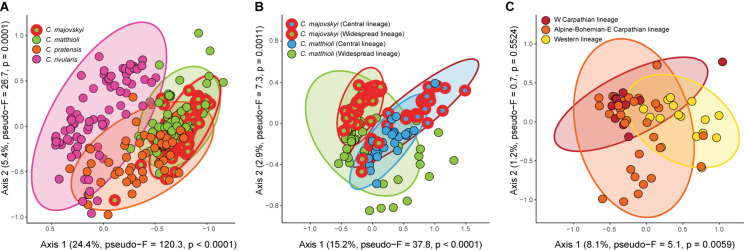
Results of RDA showing significant differences in the environmental niches of the four analyzed Cardamine species (A), genetic lineages within C. matthioli and C. majovskyi
(B), and three genetic lineages within C. pratensis
(C). Ellipses define regions expected to contain 95% of all populations of the species or lineages. Vectors of habitat characteristics contributing to the ordination axes are shown in a full version of the RDA ordination graphs in Supplementary Figure 3. Variance explained by the ordination axes and results of randomization tests are given in parentheses. The scaling of the ordination plots is focused on habitat similarity among sites.